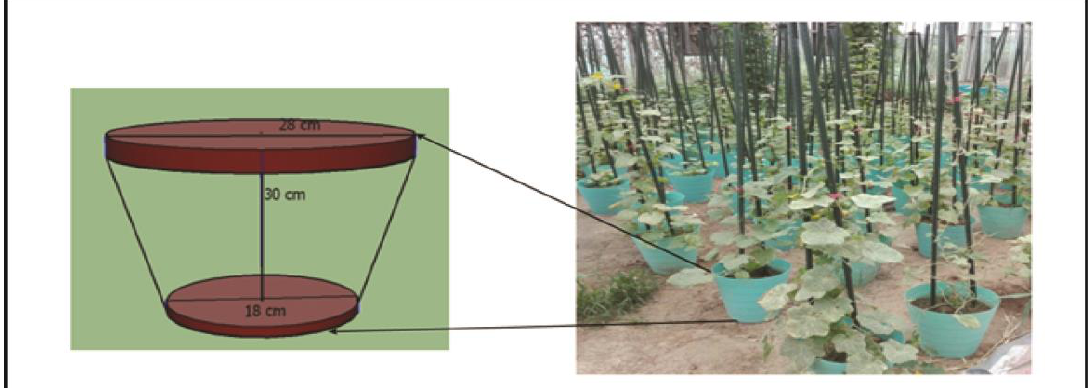
Figure 1. Experimental pot shape and size.